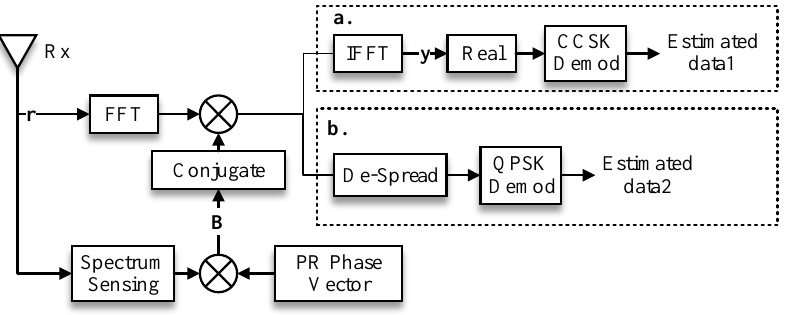
Figure 3. Block diagram of the TDCS transmitter (two modulation methods in one general diagram). Figure 3. Block diagram of the TDCS receiver (two modulation methods in one general diagram).